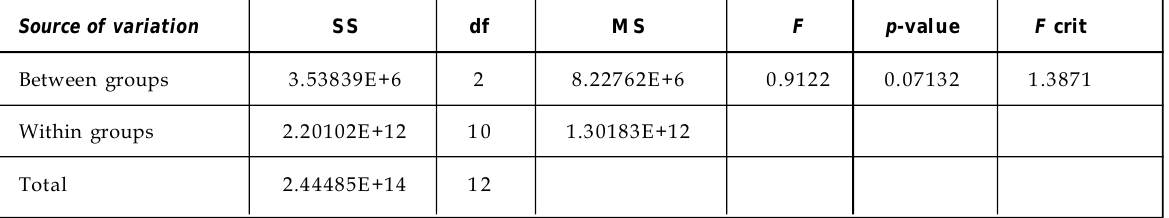
Table 2: One way-ANOVA of TVC, S. aureus and E. Coli count Source of